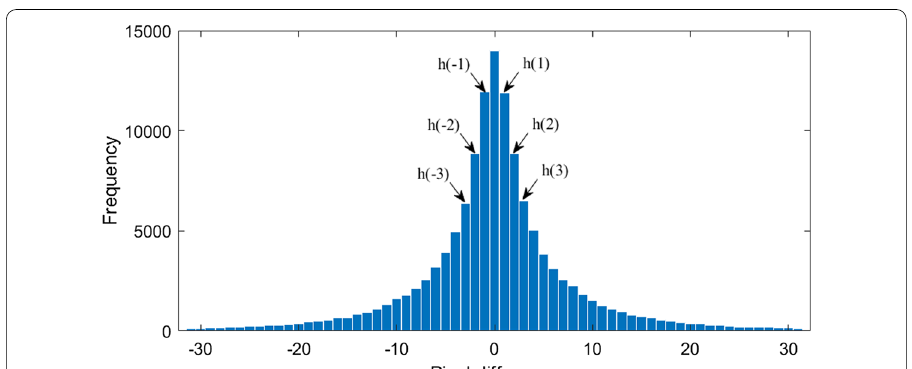
Fig. 2 Histogram of the pixel differences of a cover